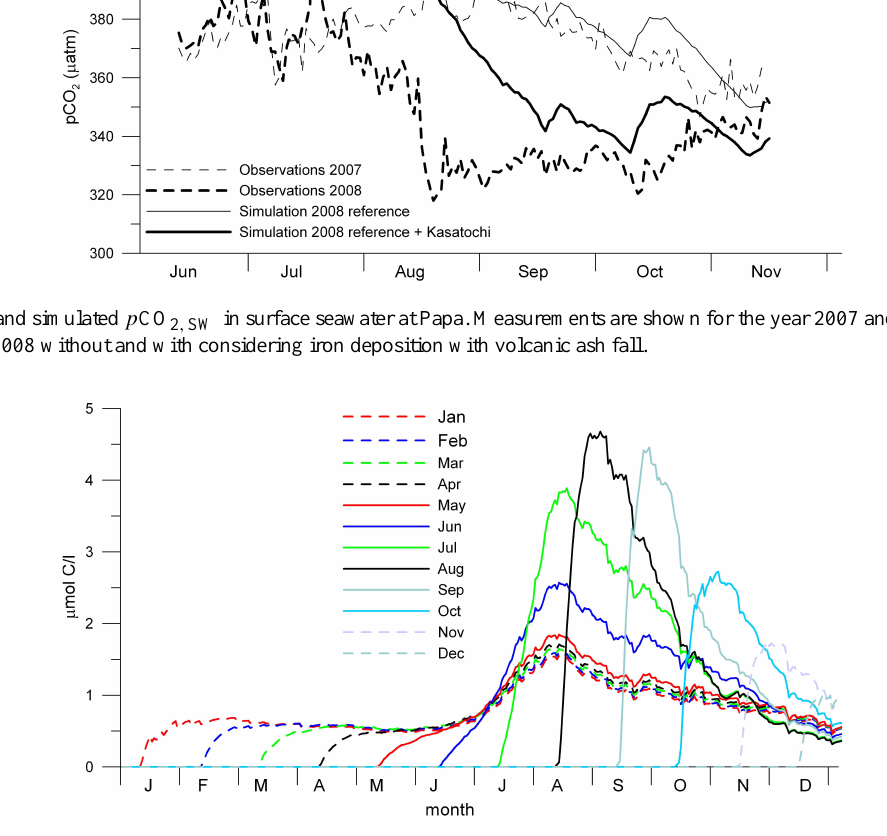
Fig. 14. Modelled increase in phytoplankton concentration at Papa in the upper 10m of the ocean as function of different iron supply